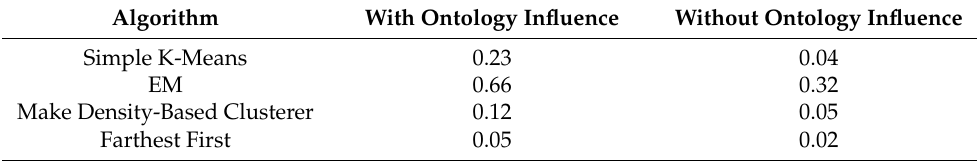
Table 6. Time in seconds to build the model of the Amazon Product Reviews